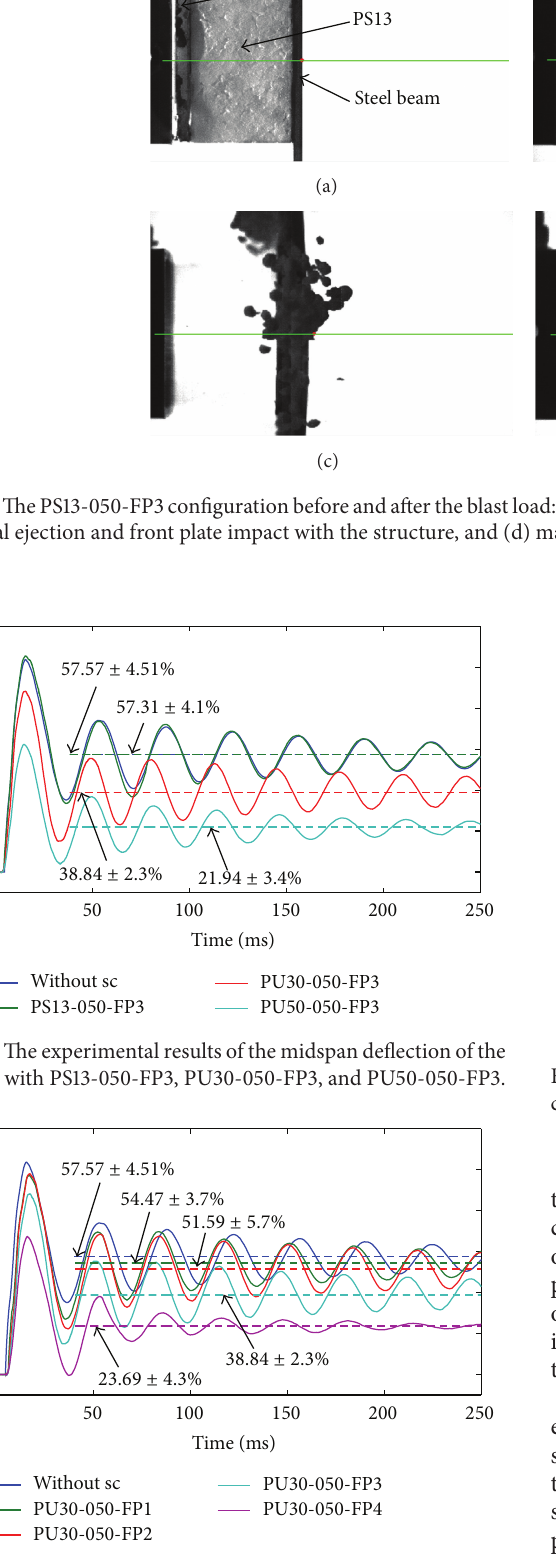
Figure 15: The effect of the front plate mass with a thickness of 50 mm of polyurethane PU30.